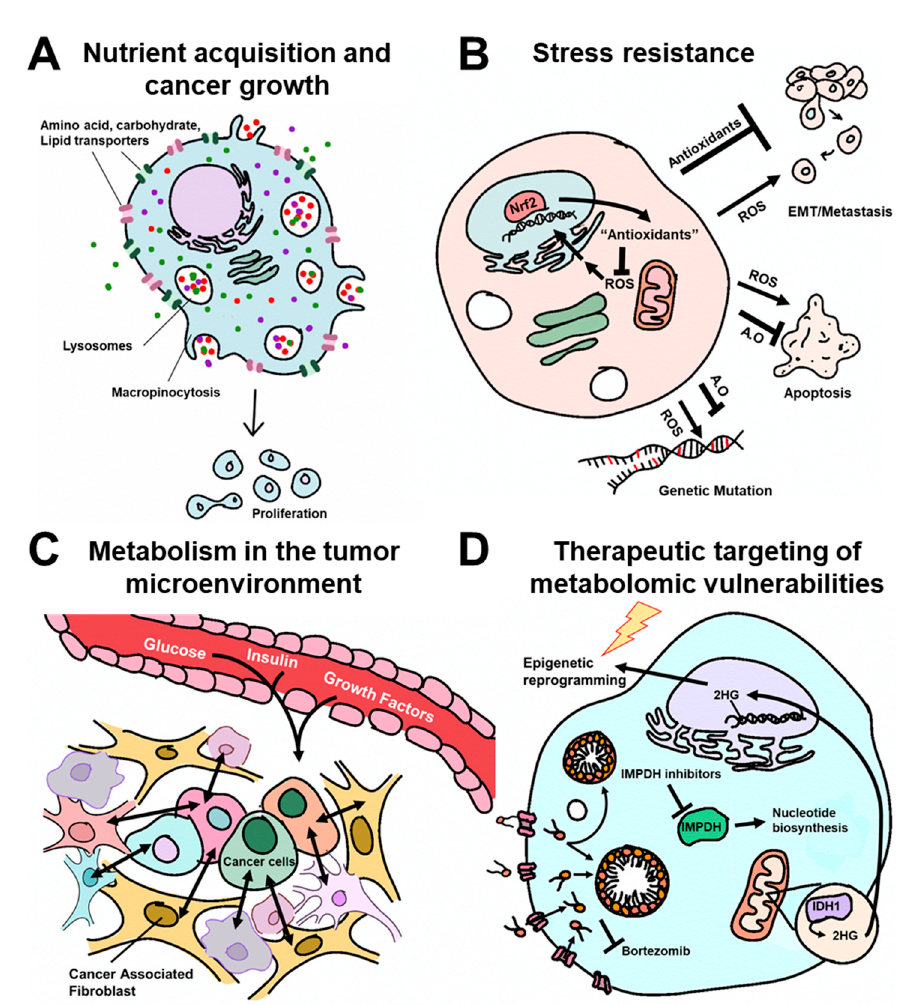
Figure 1 . Schematic overview of the themes in the Special Issue on Metabolic Reprogramming and Vulnerabilities in Cancer. A.O: Antioxidants. Figure design by Heather Giza.